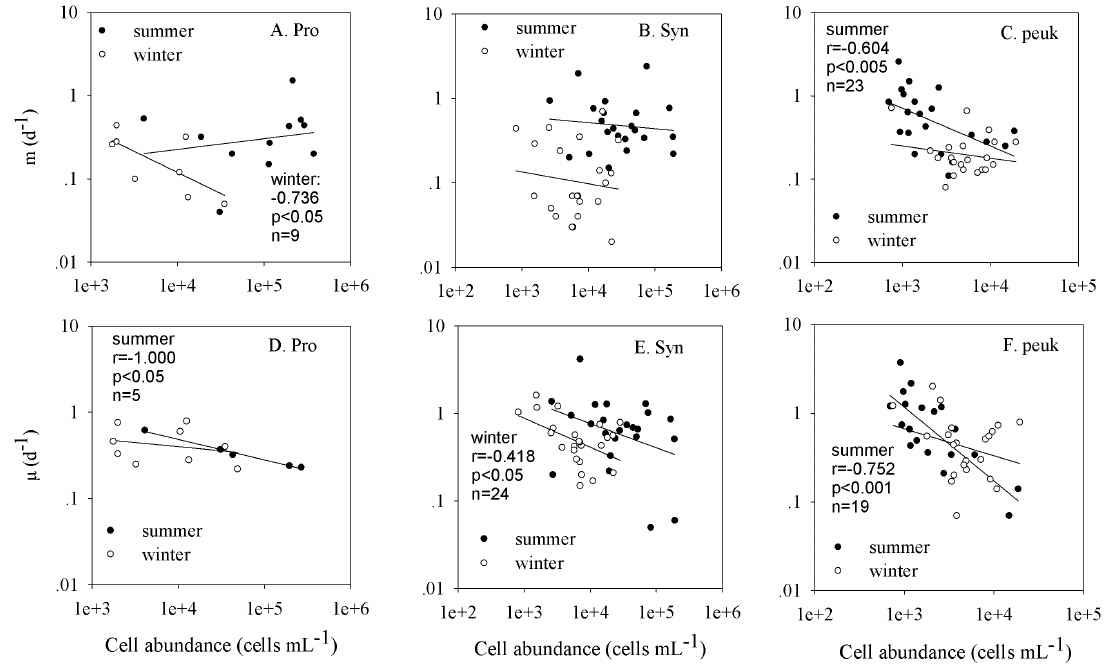
Fig. 8. Relationship between cell abundance and (A–C) grazing mortality ( m ) and (D–F) growth rate ( µ ). Solid lines are the regression curves of each season. r , p and n are correlation coefficients, statistical significance levels and number of data points.